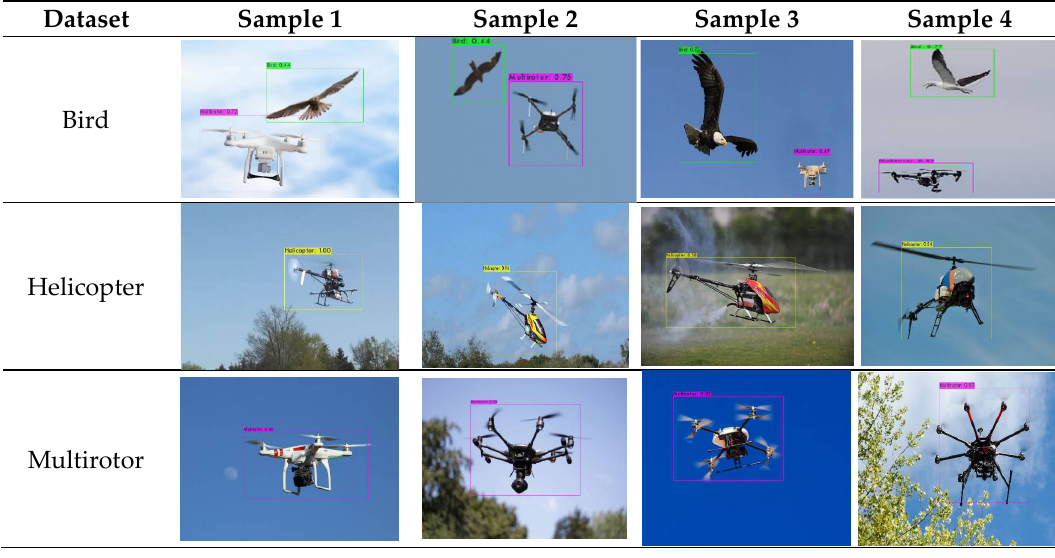
Figure 16. Some samples of detection and recognition results of the proposed network.